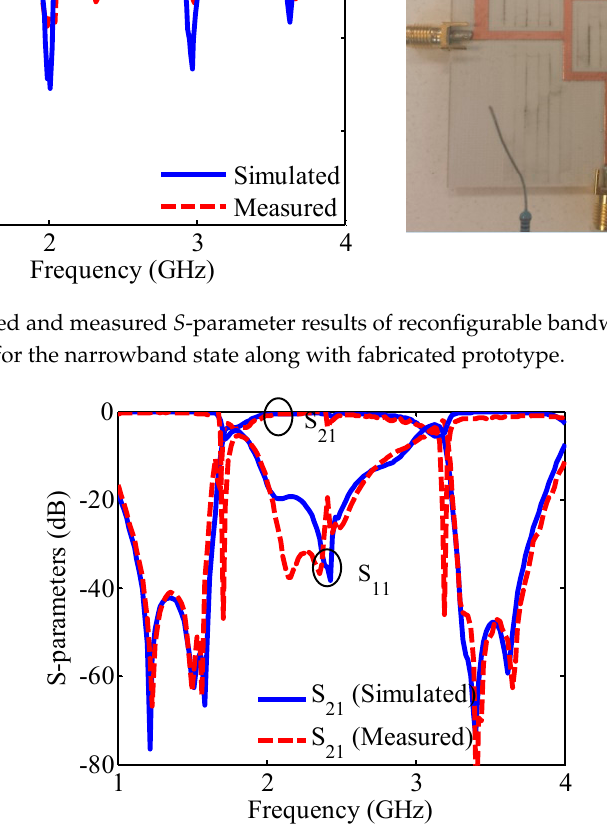
Figure 13. Simulated and measured S -parameter results of the proposed reconfigurable bandwidth BPF with λ g /2 short-ended stubs for the narrowband state along with fabricated prototype.